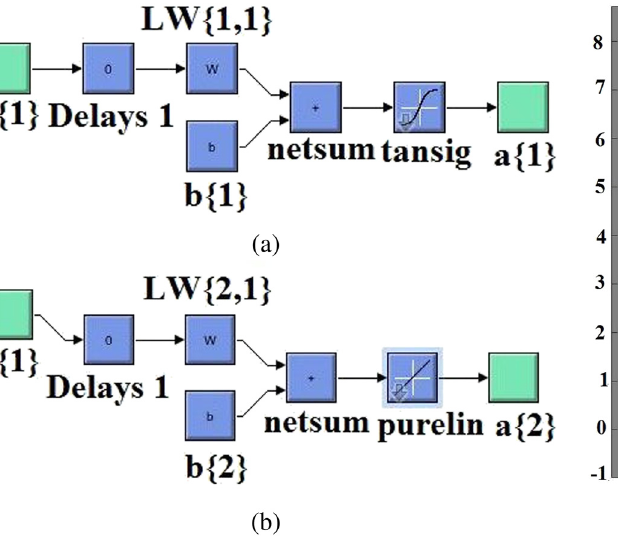
Figure 3: Block layers: ( a ) layer 1 and ( b ) layer 2.